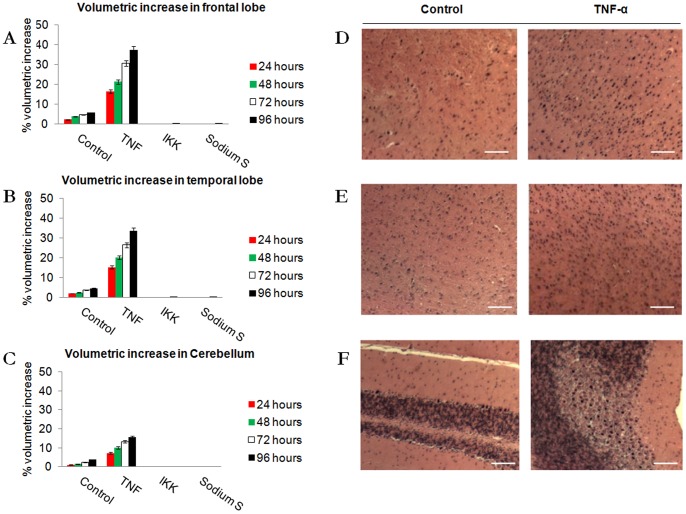
Quantification of inflammation induced by TNF-α.Tissue inflammation in Control (Ctrl), 10 ng/ml TNF-α (TNF), TNF-α with IKK Inhibitor (IKK), and TNF-α with sodium salicylate samples (Sodium S). A–C: Measurements at 24, 48, 72 and 96 hour periods in A: frontal lobe, B: temporal region, and C: cerebellum. Data is significant after 24 hours of stimulation. Results are presented as a percentage increase of original value (F = 816.22; p<0.001; df = 3,96). D–F: Confirmation of inflammation with hematoxylin and eosin (H&E) stain. Tissue stimulated with TNF-α 10 ng/ml in frontal lobe (D), temporal region (E) and cerebellum (F). Calibration bars are 50 µm.